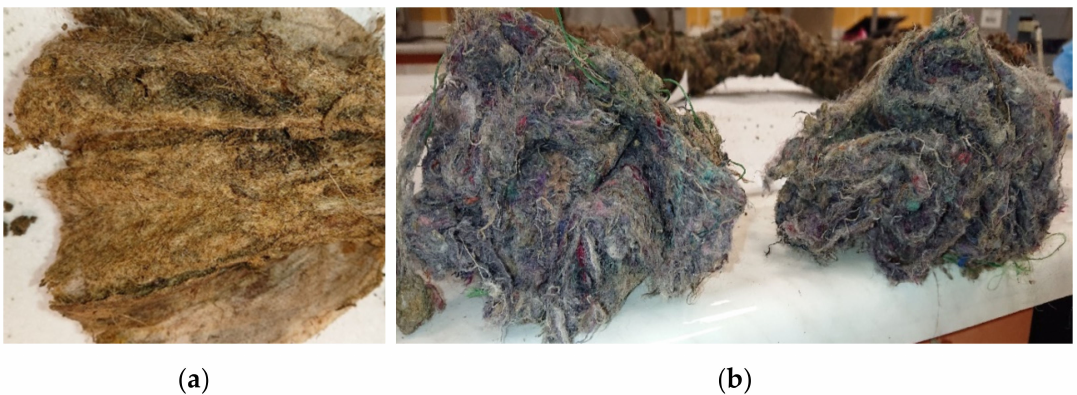
Figure 11. View of the ropes 47 months after installation. ( a ) Wool rope; ( b ) recycled natural and synthetic fiber (RNSF) ropes (left: From location 4; right: From location